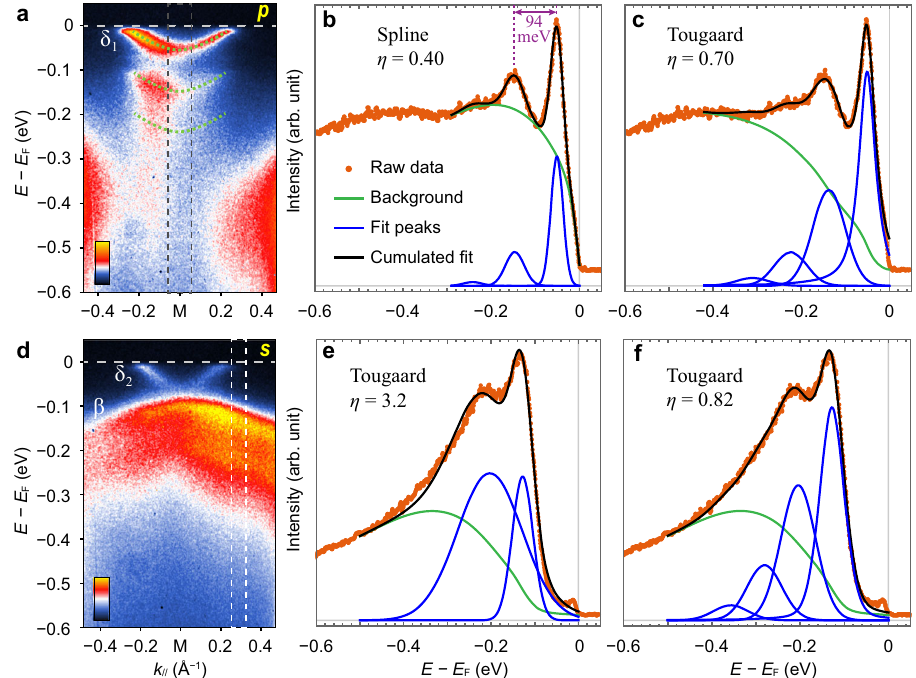
Fig. 2 Replica bands in monolayer FeSe/STO at the M point. a Photoemission intensity along cut #1 in Fig. 1a, measured with 24 eV photons in p polarization. b Energy distribution curve (EDC) at M, integrated over the momentum range indicated by the dashed rectangle in a . The background is modeled using a cubic spline interpolation and the data are fi t to three Gaussian peaks; η = I 1 / I 0 is the ratio of the areas of the fi rst replica and the principal peak. c Same as b , but with the EDC fi t with a Tougaard-type background and multiple peaks. The peak areas follow the Poisson distribution I n = I 0 ¼ η n = n ! (see “ Methods ” section for details). d Same as a but for s polarization. e EDC integrated over the momentum range indicated by the white dashed rectangle in d so that the δ 2 band is excluded and only the β band contributes. The data are fi t with a principal and a single replica peak which is unreasonably intense and broad. f Same as e , but with EDC now fi t with a principal peak and three replica peaks, using the same method as in c